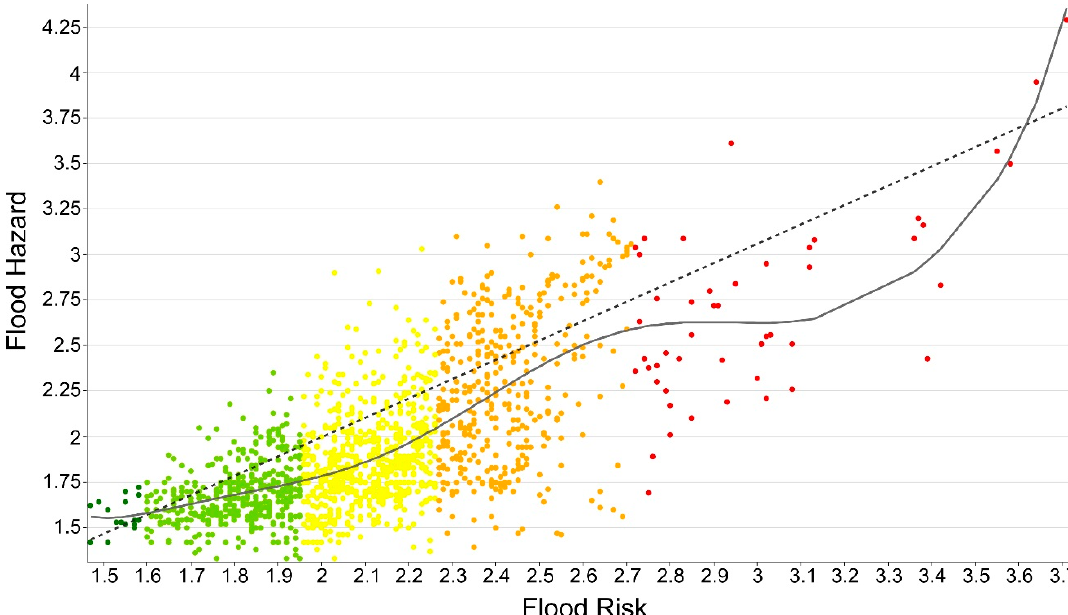
Figure 7. Flood risk vs. flood hazard values from results of the PRICAM project. Dot colors (from dark green to red) show the flood risk class (from C to A1). Dashed line shows the linear regression fit for flood risk and flood hazard values. Solid line shows the 10th order polynomial regression fit for flood risk and flood hazard values.